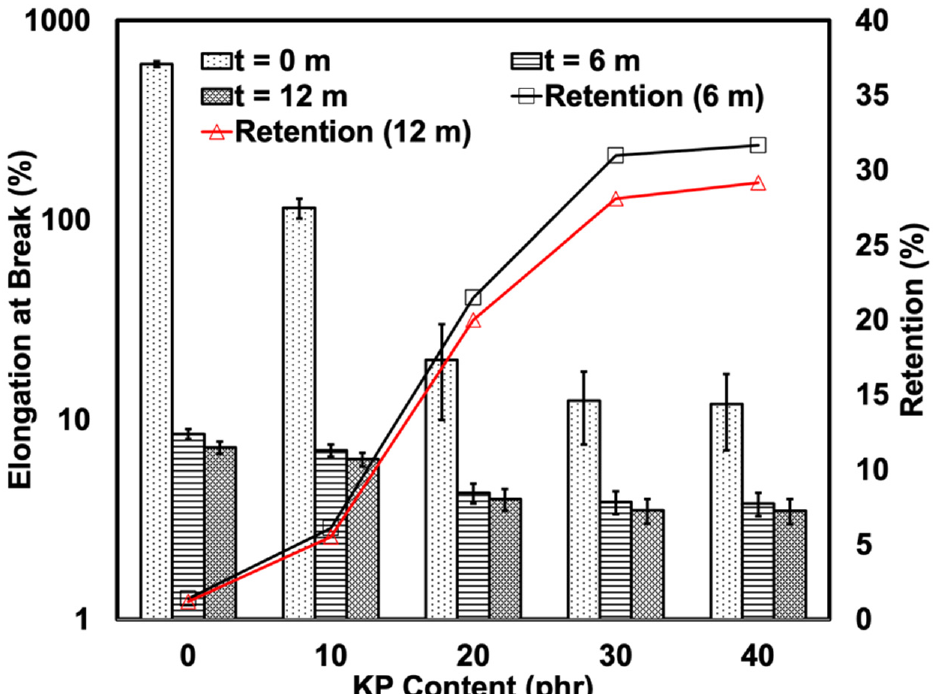
Figure 7. Elongation at break and retention of KP-filled rHDPE/NR blends before and after 6 and 12 months of natural weathering.